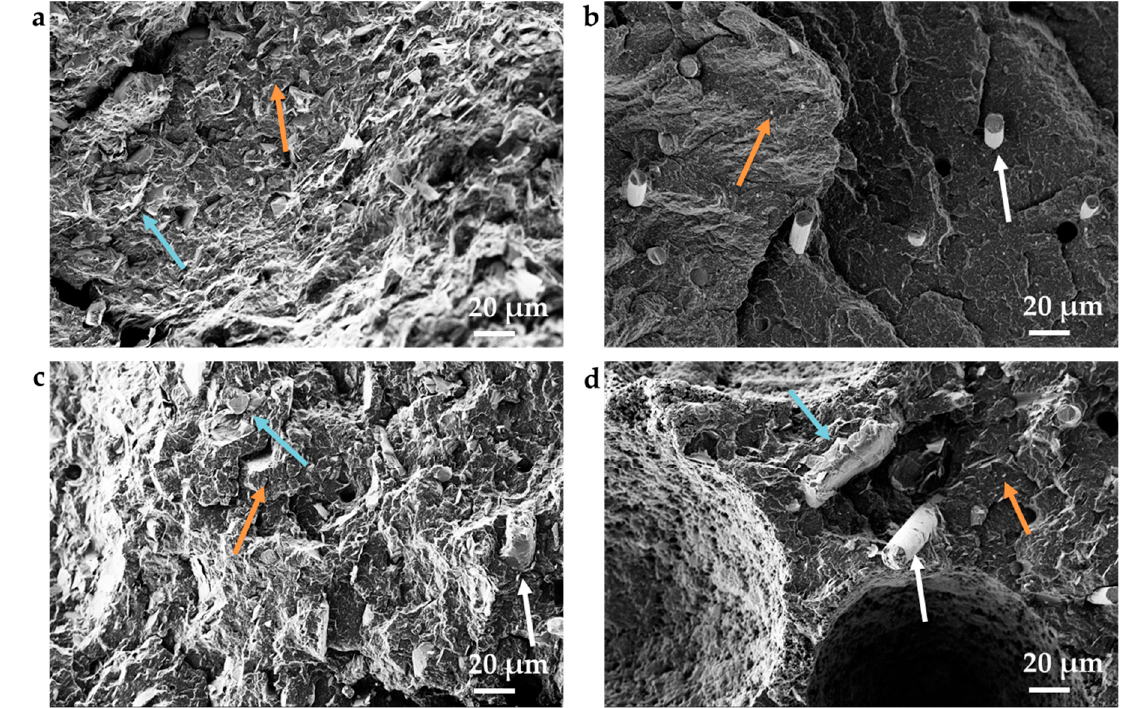
Figure 4. Scanning electron microscope images of cryofractured surfaces of PP composite strands filled with ( a ) 2.5 vol% CNT and 5 vol% GNP, ( b ) 5 vol% CNT and 2.5 vol% CF, ( c,d ) 2.5 vol% CF, 2.5 vol% CNT, and 2.5 vol% GNP (CNT: orange arrow, GNP: light blue arrow, CF: white arrow).